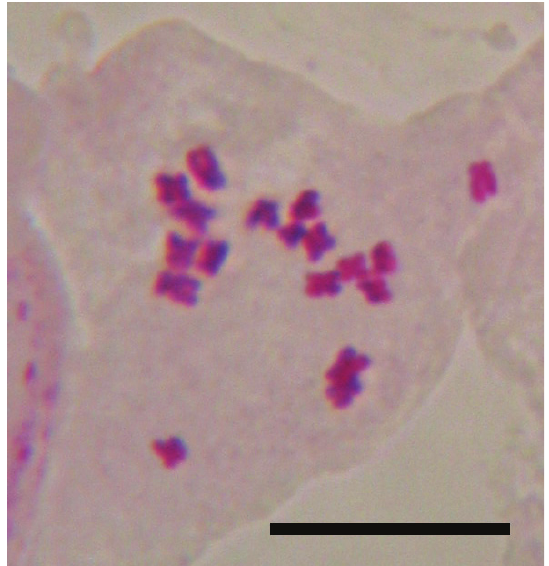
Figure 4. Centaurea poeltiana Ten., 2 n = 18. Scale bar: 10